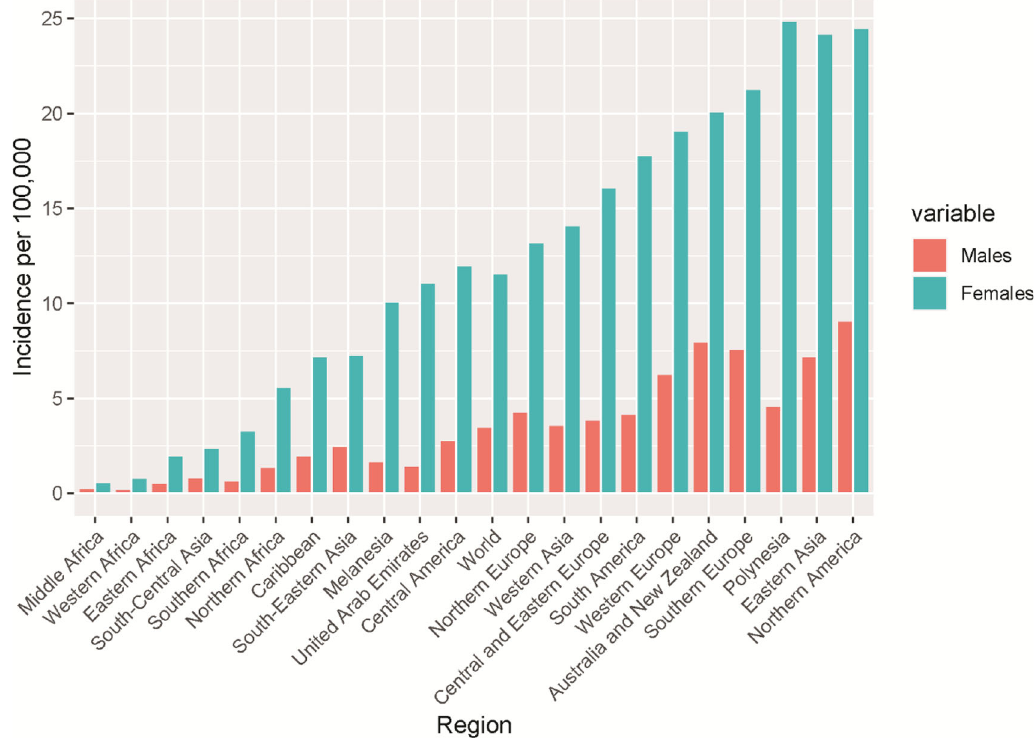
Figure 3. Number of male and female thyroid cancerincidence for selected worldregions based onthe Global Cancer Observatory data for